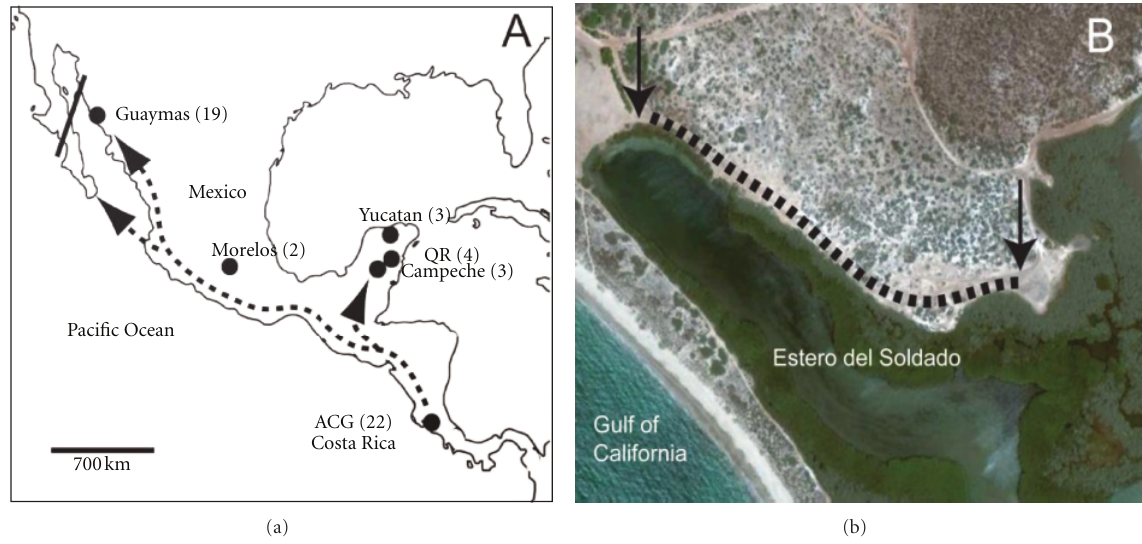
Figure 1: (a) Map showing location of sampling sites for Junonia genoveva at Estero del Soldado, near Guaymas, Sonora, Mexico and at the Area de Conservaci´on Guanacaste (ACG) in Costa Rica. The diagonal line near Guaymas represents the northern distribution limit of black mangrove in the littoral of western North America [11]. Additional GenBank records for J. genoveva from the states of Morelos, Campeche, Quintana Roo (QR), and Yucat´an in southern Mexico are also shown. The numbers of individuals from each locality are given in parentheses. Arrows show hypothesized colonization routes of J. genoveva in Mexico; (b) Google Earth satellite view of a section of Estero del Soldado and the mangrove forest lining the inner shoreline. Arrows and dashed lines show the 0.5 km route used for weekly estimations of numbers of adult J. genoveva .